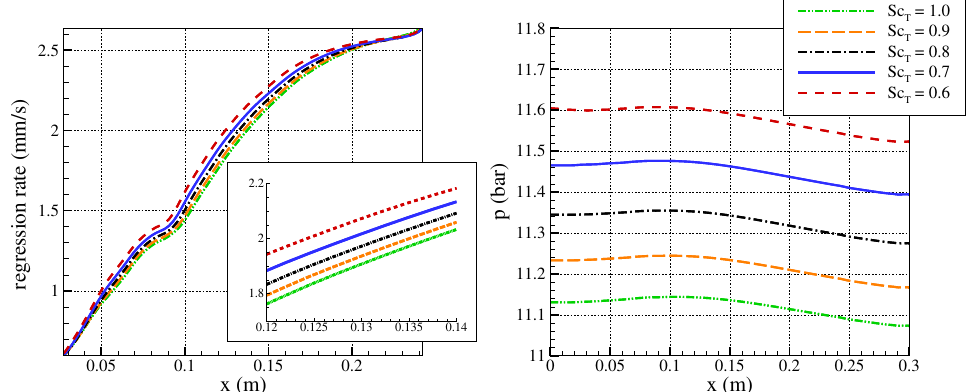
Figure 9. Effect of the turbulent Schmidt number on regression rate and